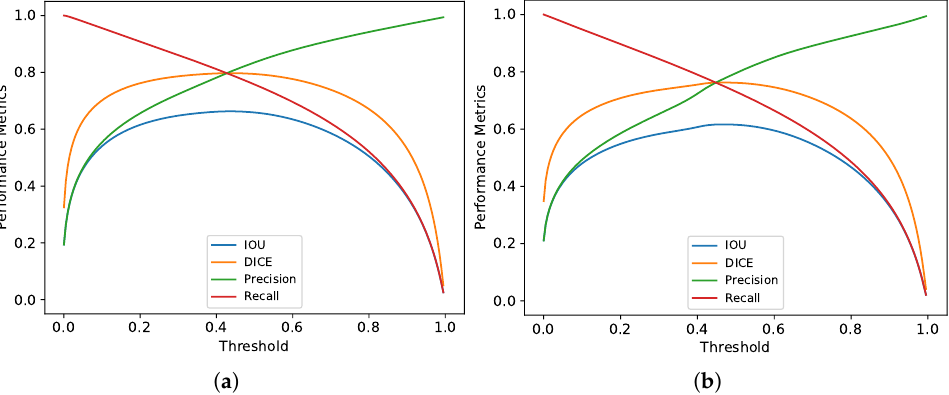
Figure 14. Sensitivity of the individual performance metrics on the actual value of the decision threshold. The optimal decision threshold with respect to DICE (=F1) score is 0.44 for GDBX L and 0.47 for GDBX L : ( a ) threshold sensitivity for GDBX L tst − unseen GDBX L tst − unseen